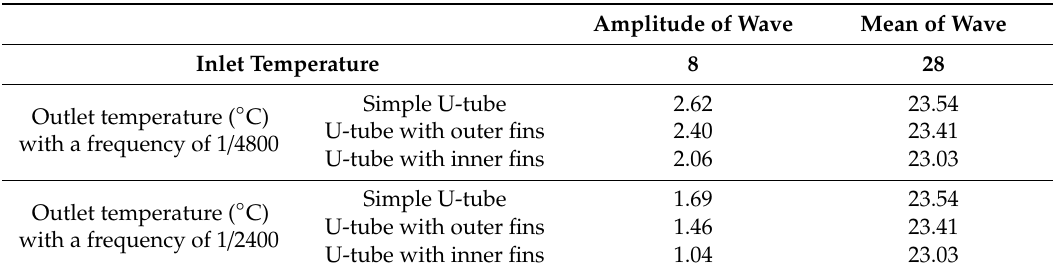
Table 7. Input and output wave characteristics with di ff erent